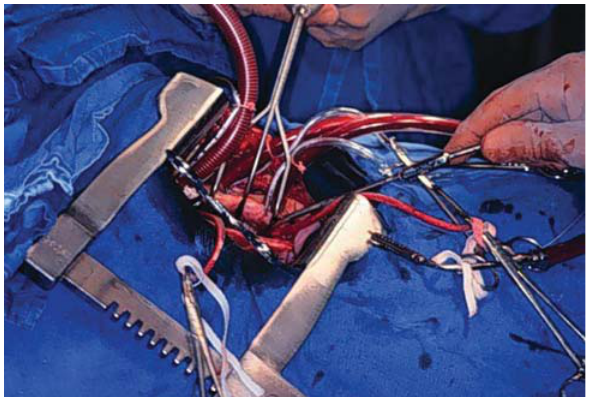
Fig. 1 - Aortic cannula position. The cannula was fixed in a column of towels to avoid kinking position